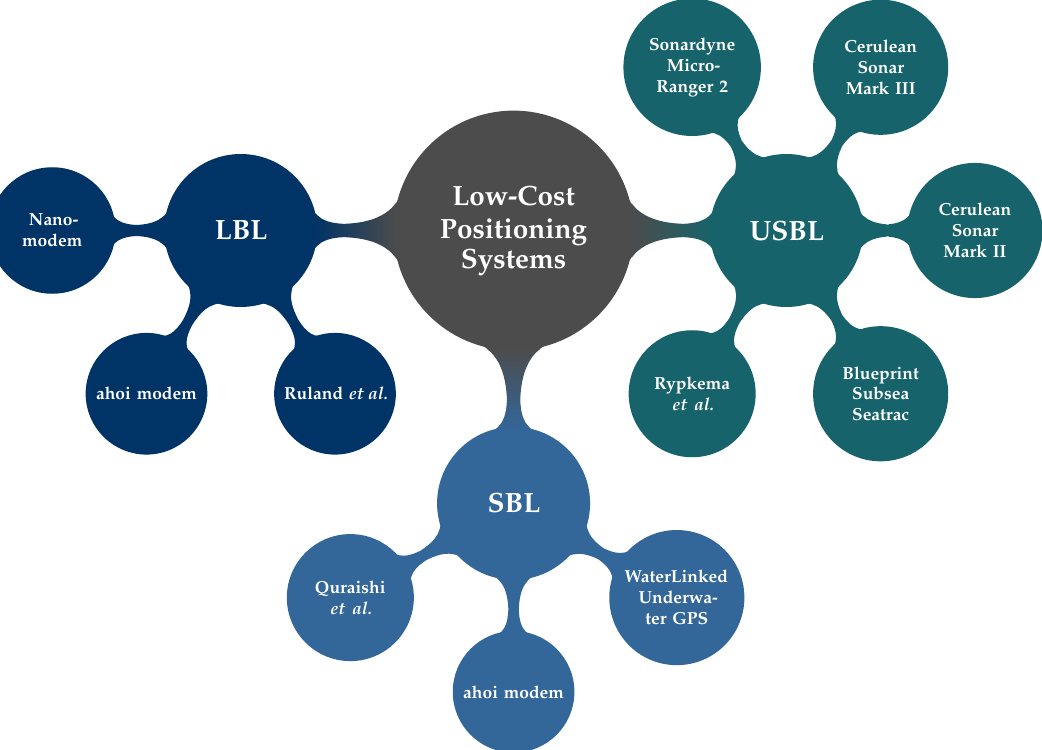
Figure 7. Summary of recent low-cost acoustic positioning systems. Abbreviations: long baseline (LBL), short baseline (SBL), ultra short baseline (USBL). (Ruland et al. [95], Quraishi et al. [92], Rypkema et al.